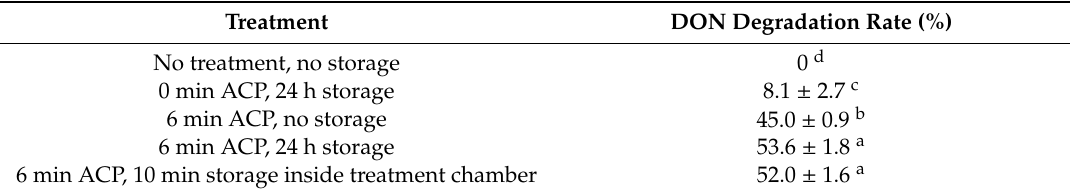
Table 4. E ff ect of post-treatment storage on DON degradation on barley by